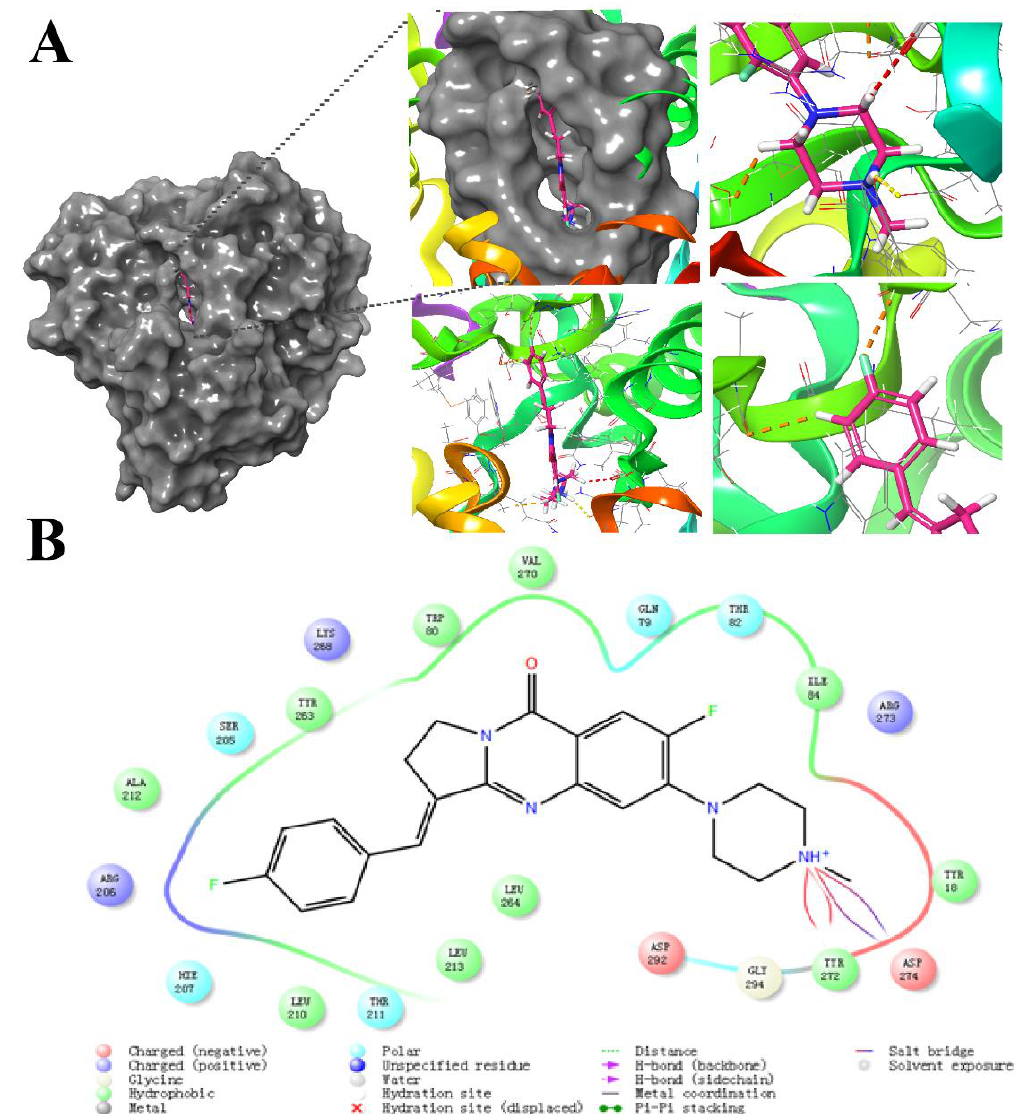
Figure 5. The result of molecular docking between BLG26 and AKT1 (PDB: 6HHF). ( A ) The binding conformation of BLG26 in the active site of AKT1. ( B ) The 2D binding conformation of BLG26 in the active site of AKT1.